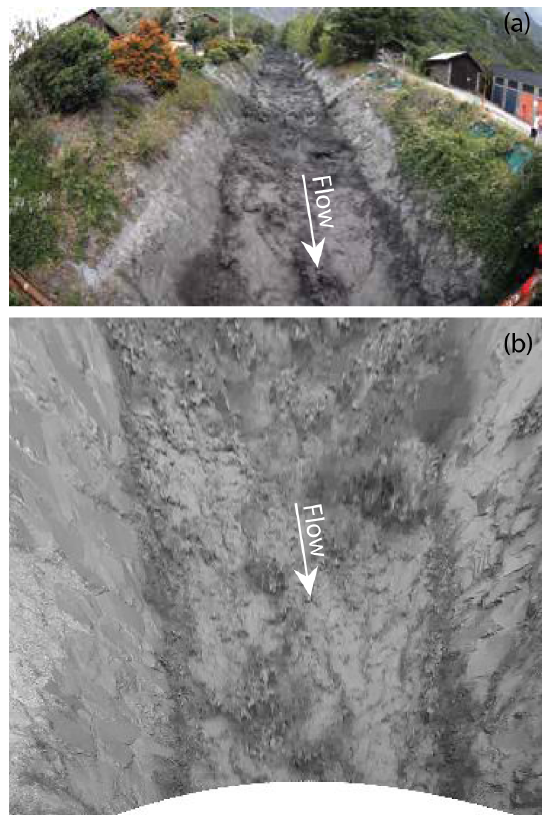
Figure 4. (a) Original footage of a flash flood in the St. Julien tor- rent acquired by a storm chaser equipped with Canon EOS 5D mark II camera. (b) Orthorectified and geometrically stable image with the field of view clipped to the lower 50% of the image. The direc- tion of flow is indicated by the